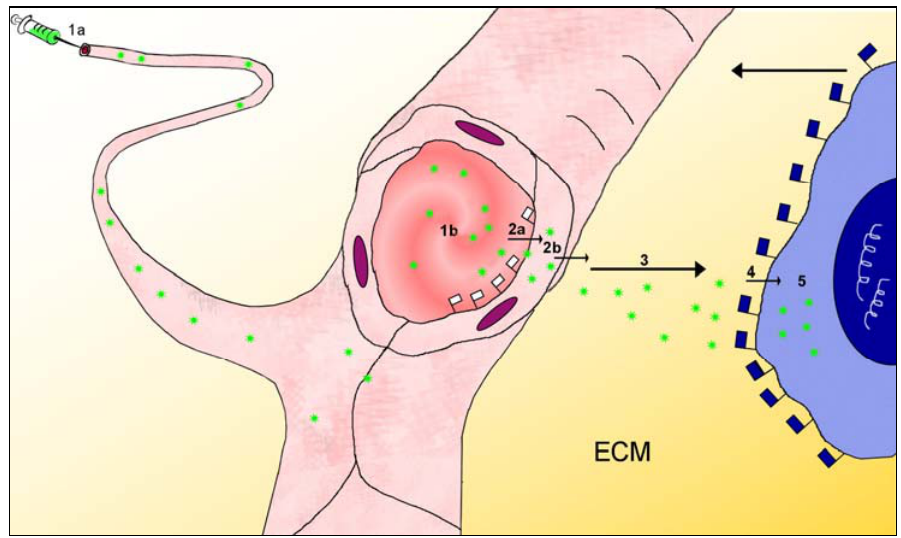
Figure 1. This sketches the first four stages of the multistage targeting path which particles (green stars) must navigate after injection (syringe, 1a) into the bloodstream (red blood in pink blood vessels), in order to access a lesion-characteristic cell such as a tumour cell (blue cytoplasm, dark blue nucleus). The injection site, top left, may be more than a meter distant from the lesion; this sketch ignores the differences between large and small blood vessels. Stage 1 begins at the injection site (1a) and ends at the patch of endothelium (1b) in a microvessel overlying the lesion; the microvessel is shown sectioned at this site. Lesion-flagging molecules embedded in the apical surface of the endothelial cells at this site (and nowhere else) (white flags) indicate that a lesion is hidden behind the microvessel wall at this site; at this point the particles leave the bloodstream ( stage 2a ), cross the endothelial cell forming the microvessel wall (2b) and enter the sub-endothelial interstitial compartment (“perivascular space”). Stages 2a and 2b together require the particle to pass across the endothelium, which is the usual site for the blood-tissue barrier; the distance across the endothelial wall is approximately 0.000002 meters = 2 µm. Stage 3 of